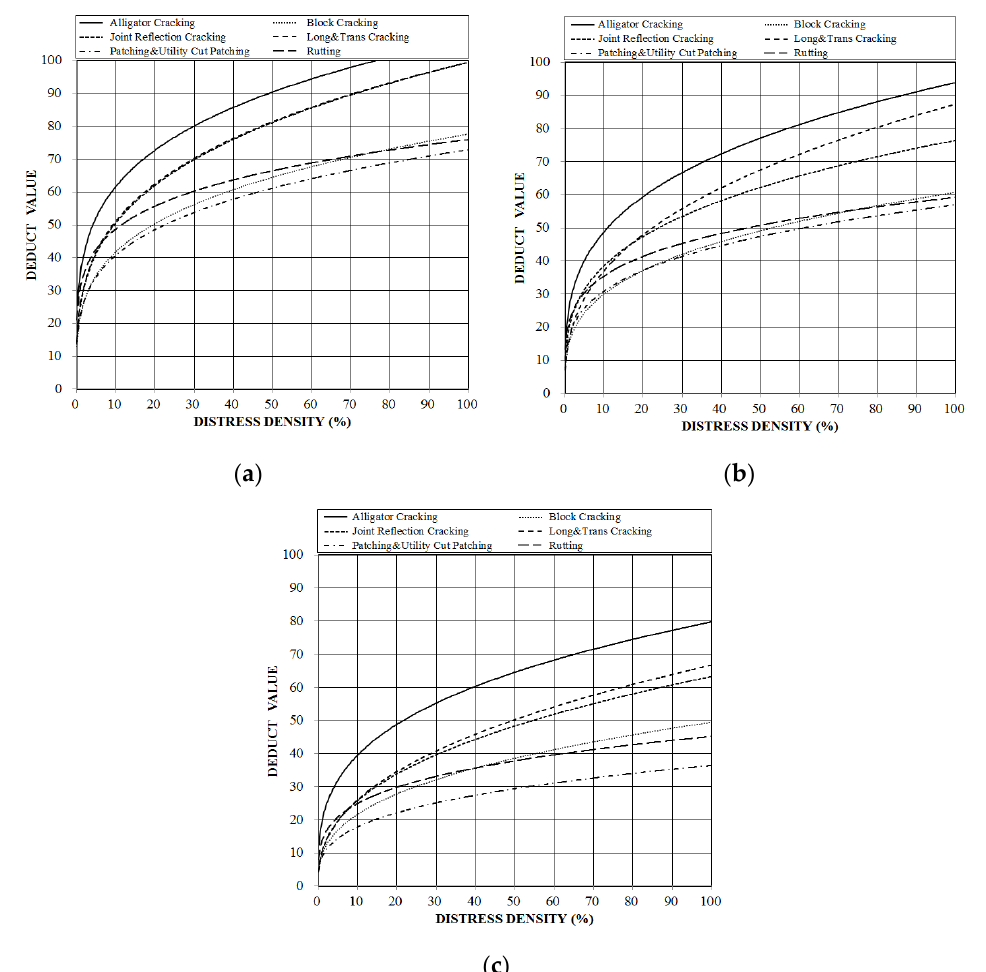
Figure 6. Developed deduct value curves of all distress types of asphalt pavement at ( a ) High Severity level, ( b ) Medium severity level, and ( c ) Low severity level.